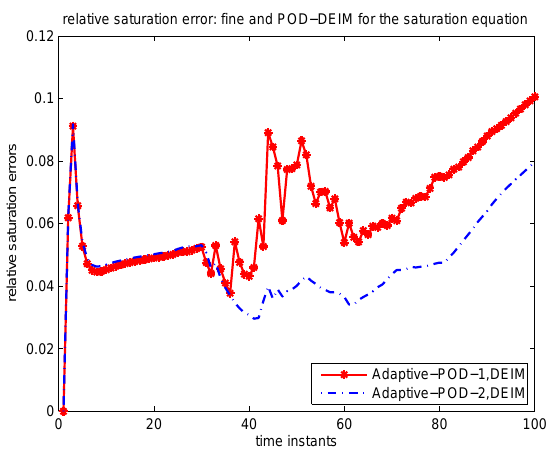
Figure 13. Water-cut of online adaptive POD-DEIM for the saturation equation.